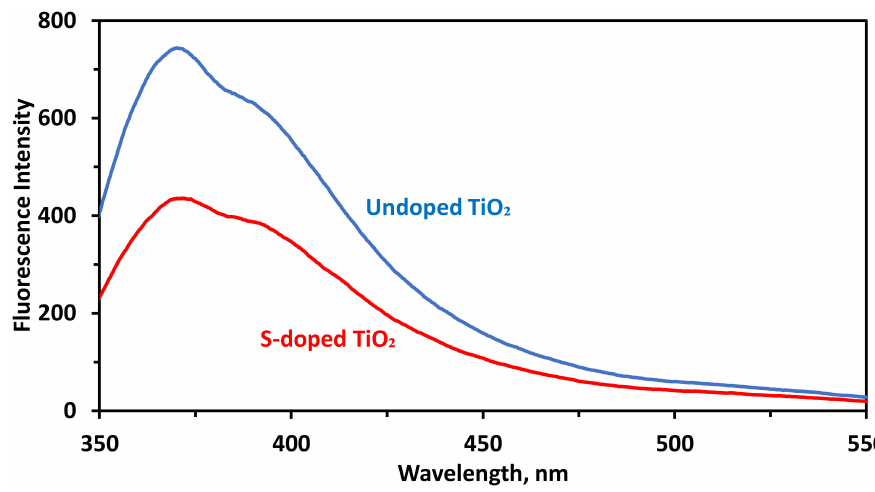
Figure 4. Fluorescence emission spectra of undoped and S-doped TiO 2 photoanode thin